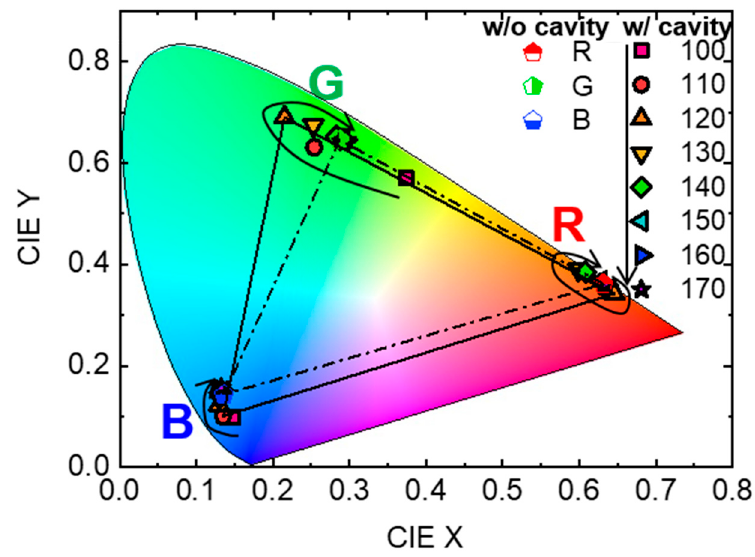
Figure 2. Commission Internationale de L’Eclairage (CIE) 1931 chromaticity diagram with optically simulated colour coordinates and the gamut of R, G, and B devices with (solid line) and without (dash line) micro-cavity structure embedded cathodes.